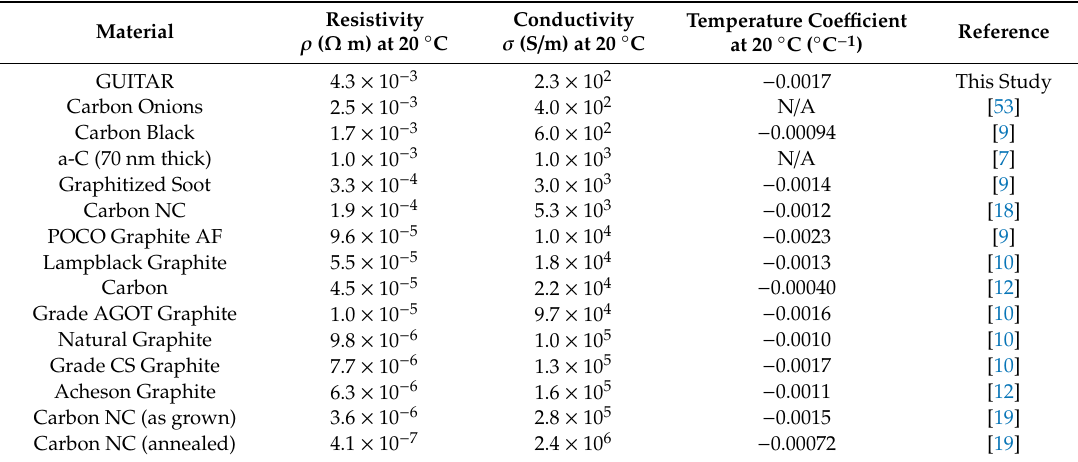
Table 3. Comparison of the resistivities, conductivities, and TCOR values for a variety of materials, including